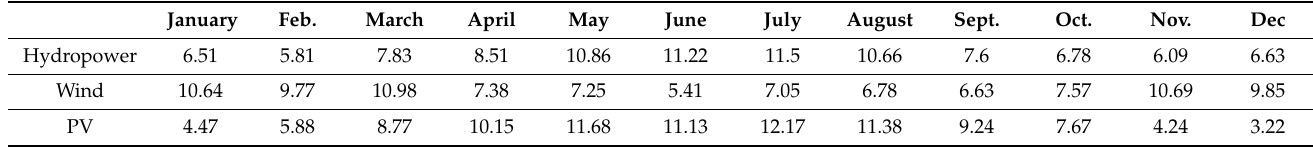
Table 3. Monthly distribution of electricity generation from hydropower, wind, and PV in Austria in